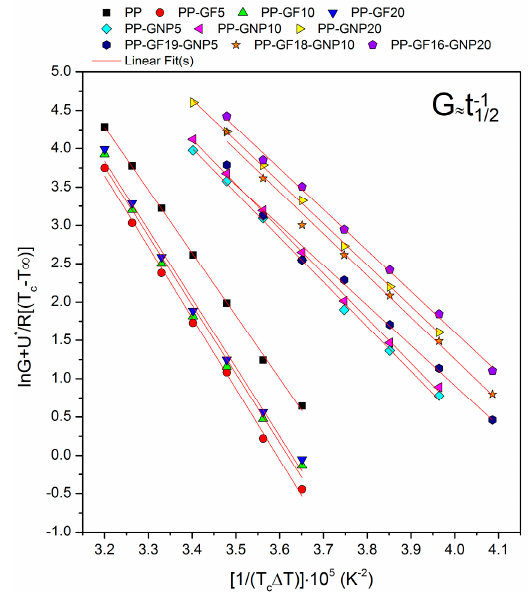
Figure 4. Lauritzen–Hoffman plots of PP and the composites.